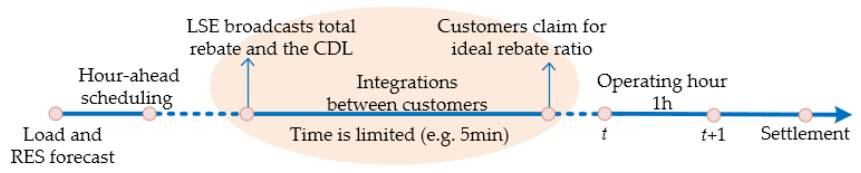
Figure 1. Timeline of the proposed DR scheme.